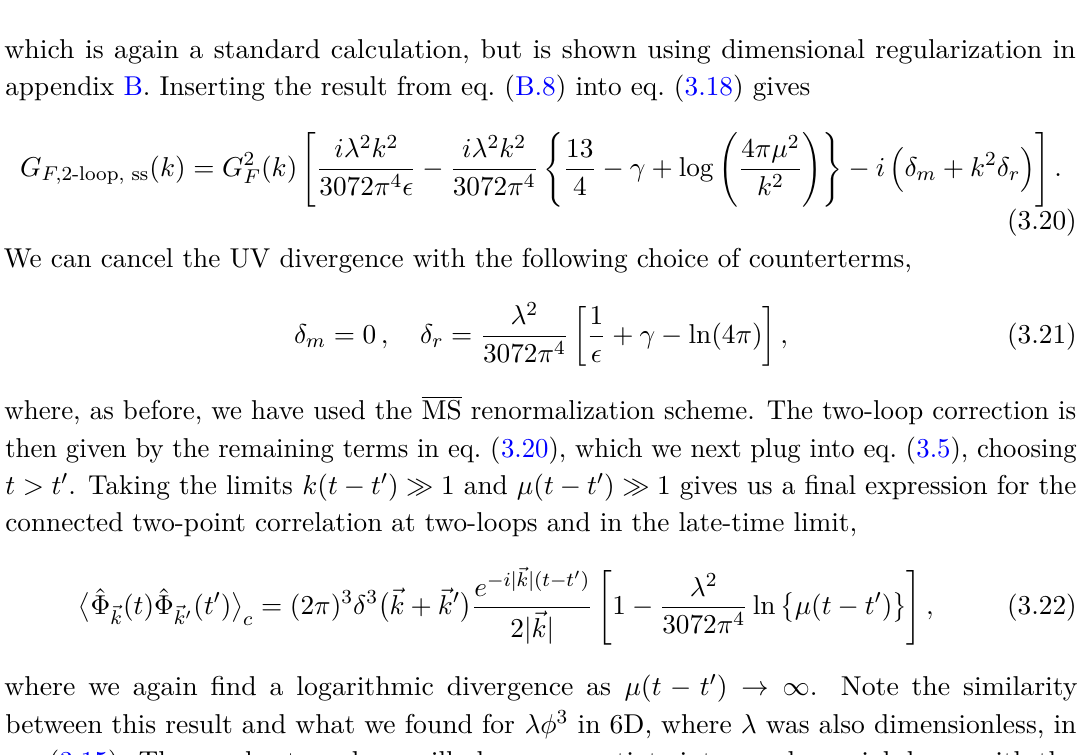
Figure 4 . (Left) Connected two-loop contributions to the two-point correlation function in a λφ 4 theory. (Right) The corresponding δ m and/or δ r counterterm